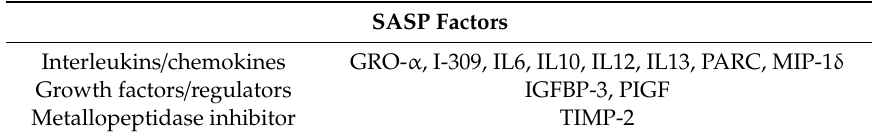
Senescence-associated secretory phenotype (SASP) factors significantly induced by overexpression of miR-34a in